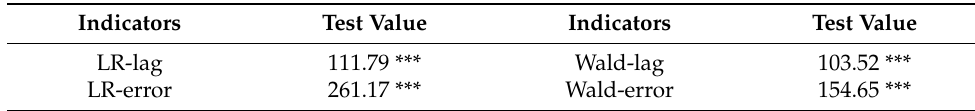
Note: *** indicate significance at the 1% levels, respectively.